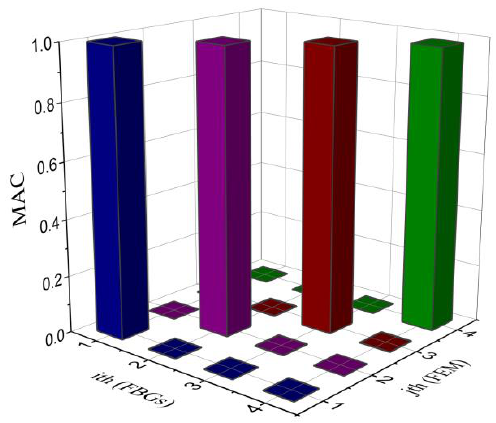
Figure 8. MAC correlation of strain mode shapes between the results of experimental testing and FEA calculation.